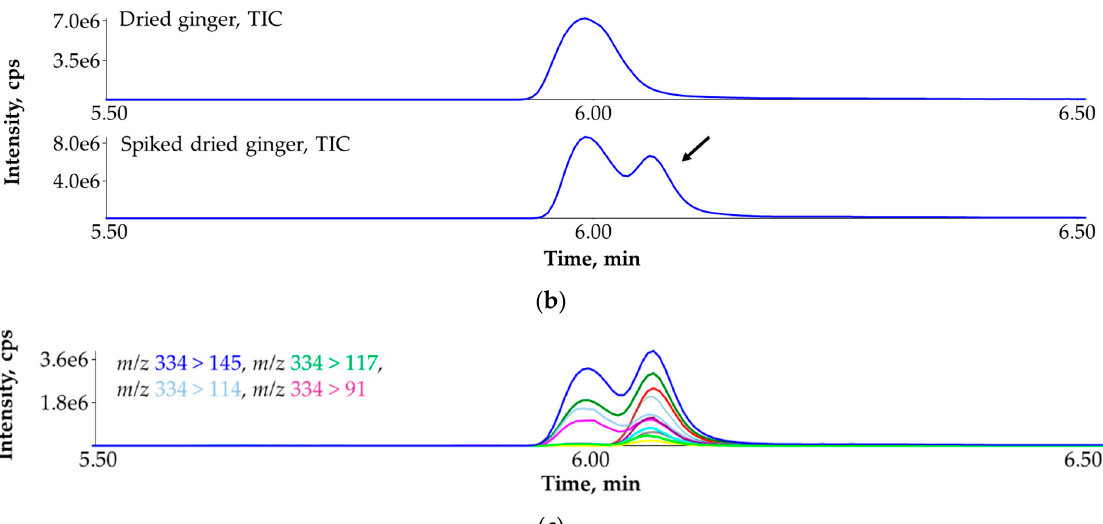
Figure 6. ( a ) Screening analysis of a dried ginger sample. The ion transitions of tebufenpyrad in a neat solvent calibrant (100 ng/mL, above) and in the sample (below). ( b ) Confirmatory analysis of a dried ginger sample for tebufenpyrad using standard addition (0.010 mg/kg). Figures show the total ion chromatograms (TICs). ( c ) Confirmatory analysis of a dried ginger sample for tebufenpyrad using standard addition. The target compound elutes at 6.05 min. Ion transitions were as follows: blue line ( m / z 334 > 145), green line ( m / z 334 > 117), light blue line ( m/z 334 > 114), purple line ( m/z 334 > 91).